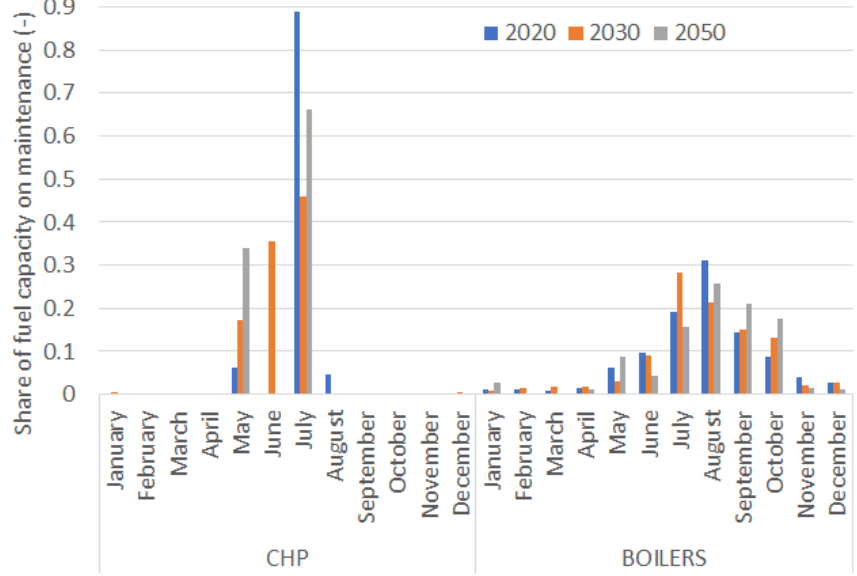
Figure 3. The share of capacity on maintenance of district heating units burning waste in